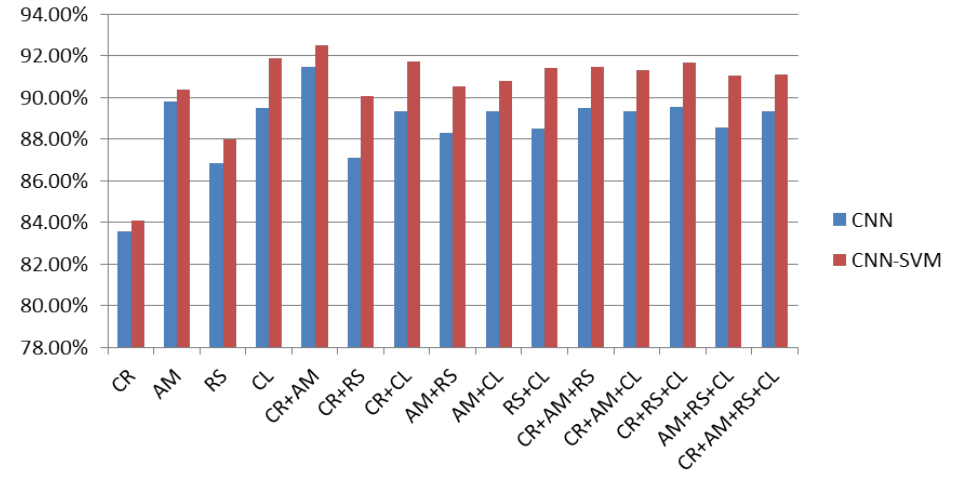
Figure 6. Fusion of CNN-SVM as substitute of CNN softmax